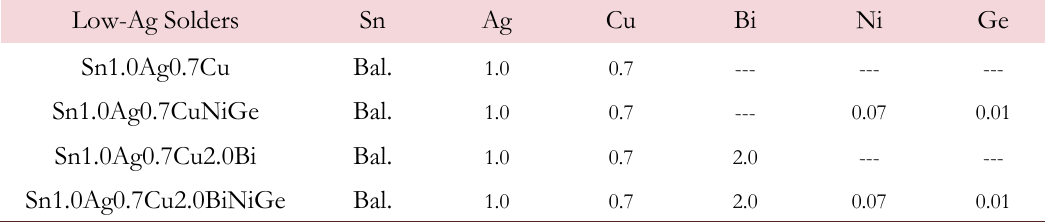
Table 1: Chemical composition of material tested